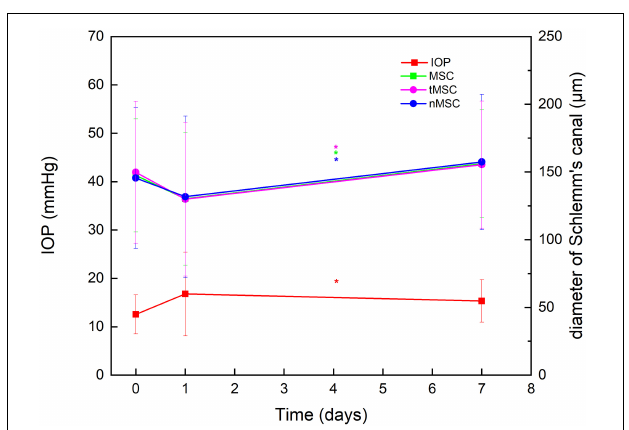
FIGURE 2 | Plotting line showing the significantly opposite variation trends of intraocular pressure (IOP) against nasal meridional diameter of Schlemm’s canal (nMSC), temporal meridional diameter of Schlemm’s canal (tMSC) and MSC before surgery, on day 1 after surgery, and at 1 week after surgery. *Indicates statistical difference between date groups.